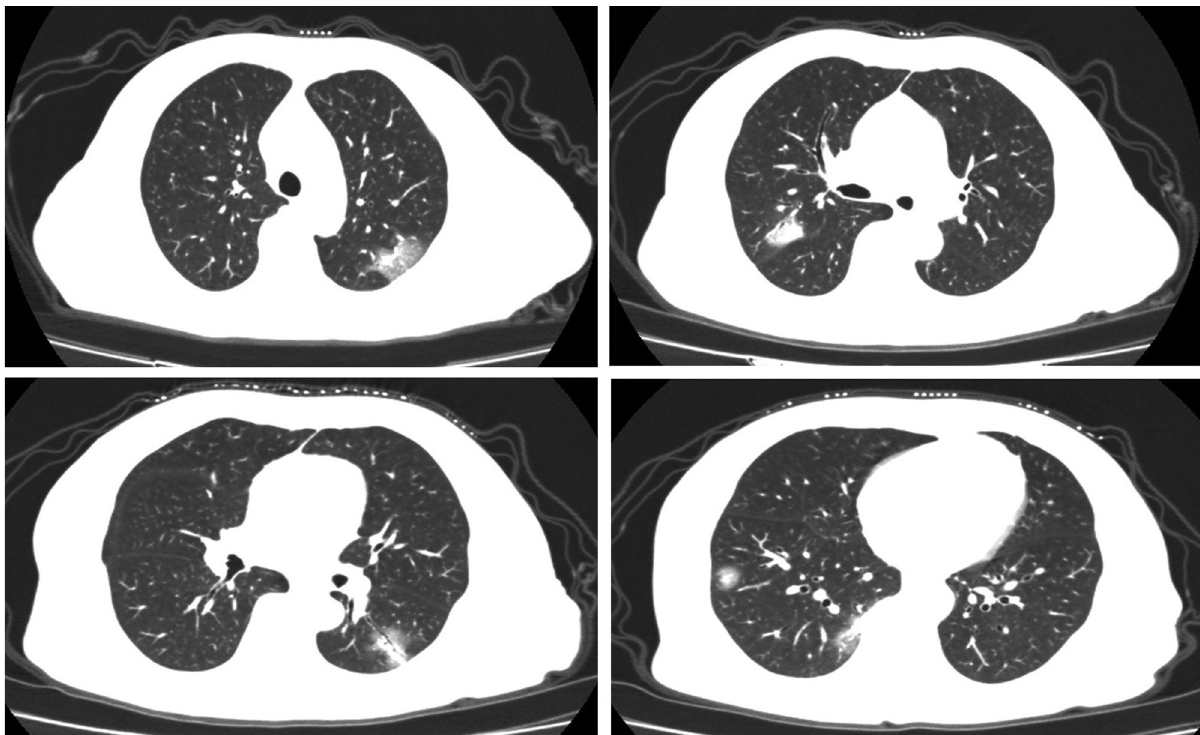
Figure 1: Case 1: CT chest result showed multiple peripheral solid and ground - glass images on bilateral